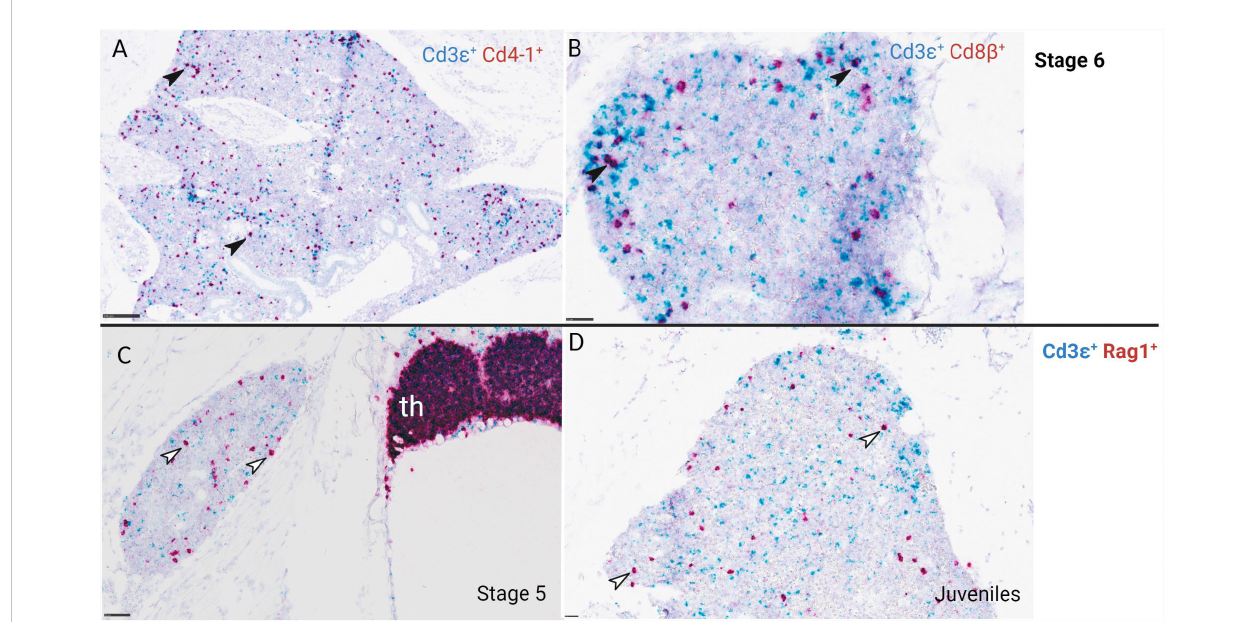
FIGURE 7 RNA scope in situ hybridization of ballan wrasse head kidney from larvae at stage 5, 6, and juveniles. (A) CD3 ϵ + (blue) and CD4-1 + (red) cells, larva at stage 6. (B) CD3 ϵ + (blue) and CD8 b + (red) cells, larva at stage 6. Black arrows indicate double stained lymphocytes that are either CD3 ϵ + CD4-1 + T- cells or CD3 ϵ + CD8 b + T-cells. (C, D) show CD3 ϵ + (blue) and RAG1 + (red) cells of larvae at stage 5 and juveniles correspondingly. White arrows indicate RAG1 + cells in the head kidney. Th, thymus. Scale bars: (A) 50 µm, (B) 50 µm, (C) 100 µm, (D) 25